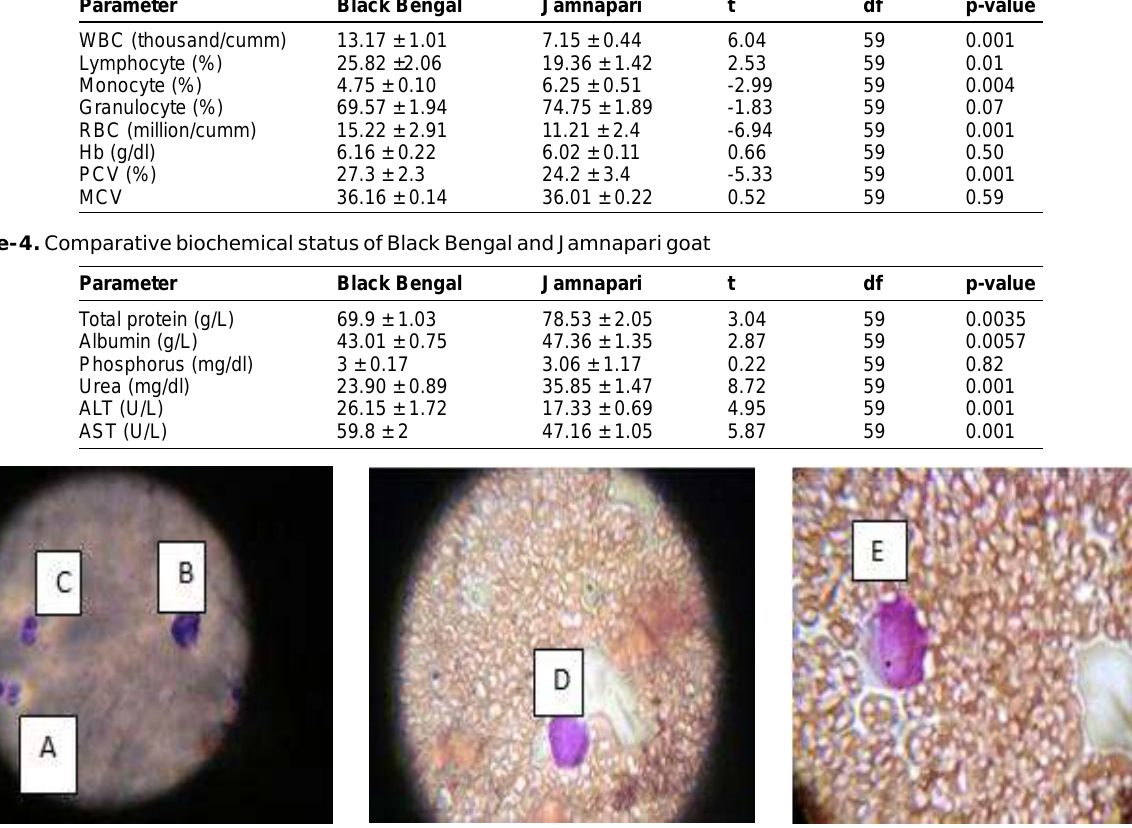
Table-3. Comparative hematological status of Black Bengal and Jamnapari goat Parameter